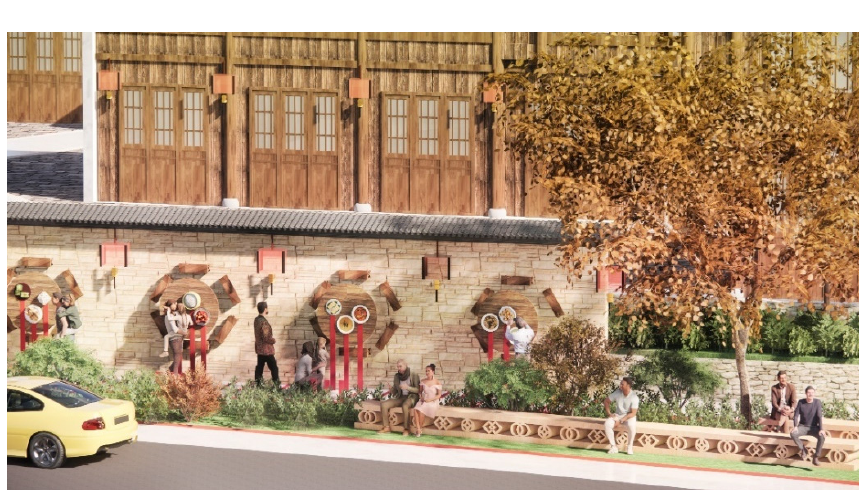
Figure 10. Dishes display wall.